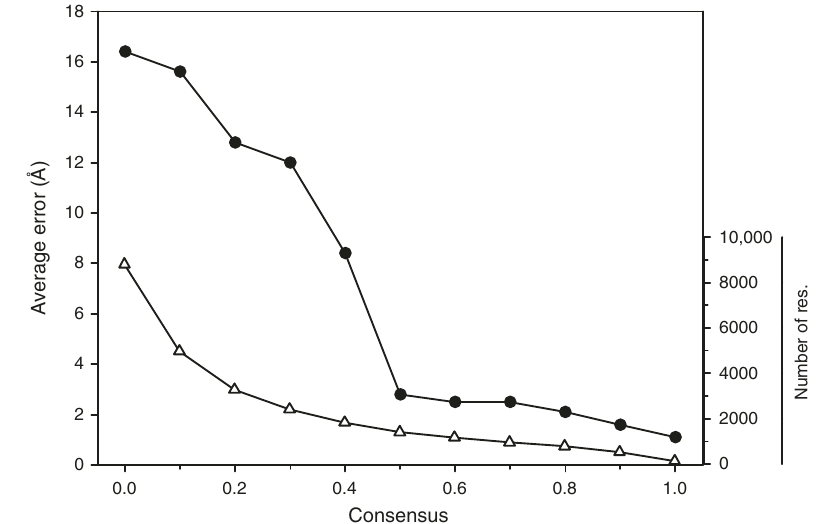
Fig. 6 Average accuracy of residue positions relative to the degree of consensus among top 100 models for the 30 real EM maps. C α positions of top 1 scoring model of 28 experimental EM maps were compared from those from top 2 -99 models, which were ranked by the MDFF score. Two maps, EMD- 3073 and EMD-8116 were excluded because the top 1 protein models generated for these two maps were exceptionally bad (RMSD: 40.42 Å and 49.78 Å, respectively). Consensus on the x -axis shows the fraction of the models that have a residue within 3.5 Å. Black circles, the average error of each C α positions (the bar on the left) of top 1 scoring model relative to the consensus fraction. Triangles, the total number of residues in the 30 models (the bar on the right) that have a certain consensus value. It is evident that the quality of regions with a consensus of 0.5 or higher are modeled well, on average within less than 3.0 Å Table 1 Comparison with RosettaES on the data set of 44 fragments Criteria Number of cases